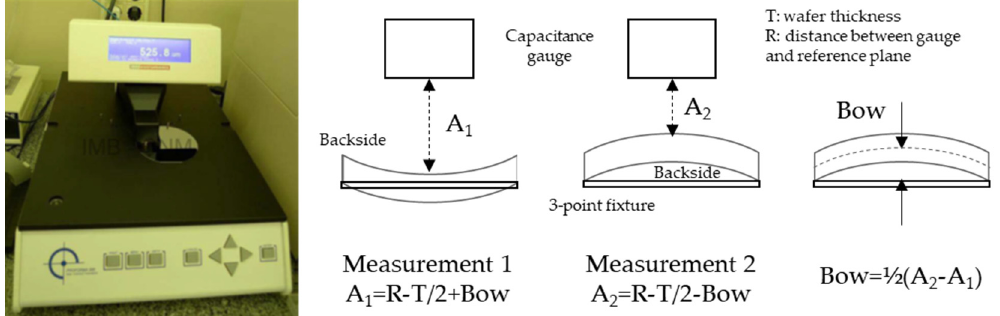
Figure 5. Bow measurement: picture of the Proforma300 in the Microelectronics Institute of Barcelona (IMB-CNM) clean room ( left ) and measurement method ( right ).